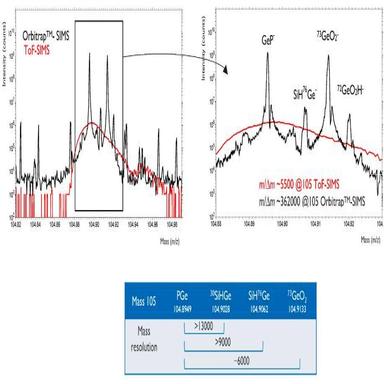
Orbitrap™-SIMS (black line) and ToF-SIMS (red line) mass spectra at 105 m/z measured on a SiGe:P reference sample and the mass resolutions needed to resolve possible interferences between ions.